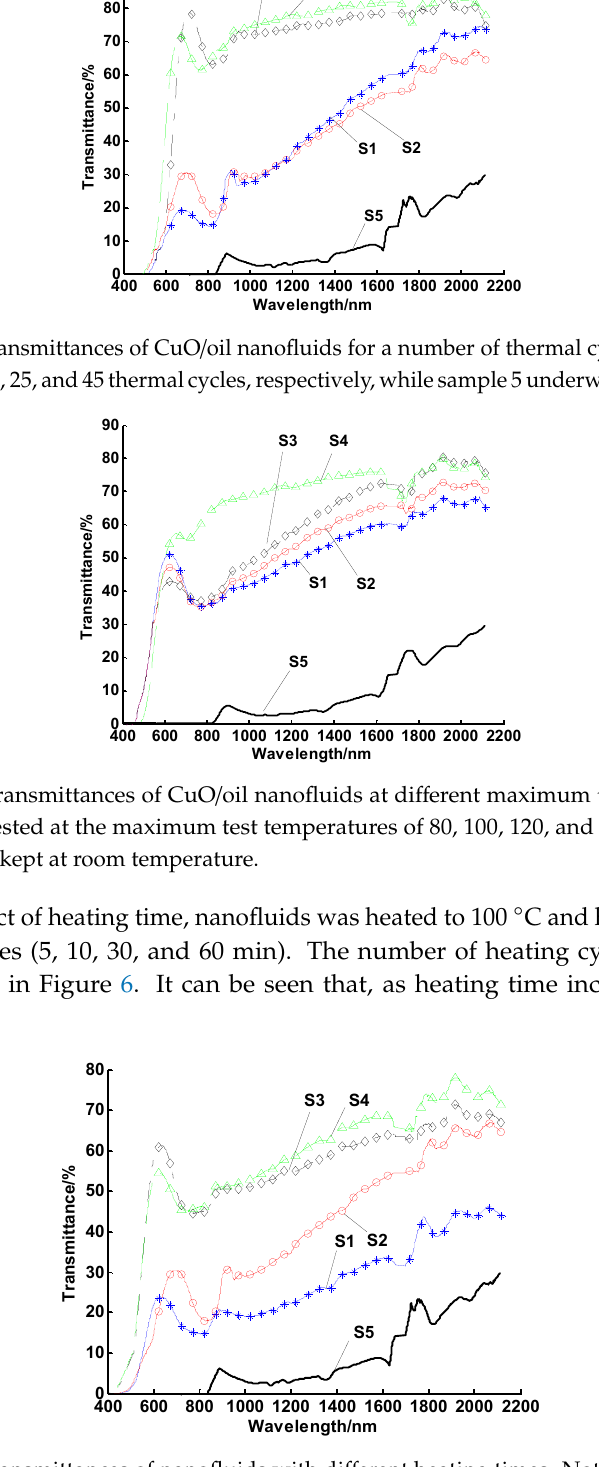
Figure 6. Spectral transmittances of nanofluids with di ff erent heating times. Note: samples 1–4 were tested for heating times of 5, 10, 30, and 60 min, respectively, while sample 5 experienced no heating.